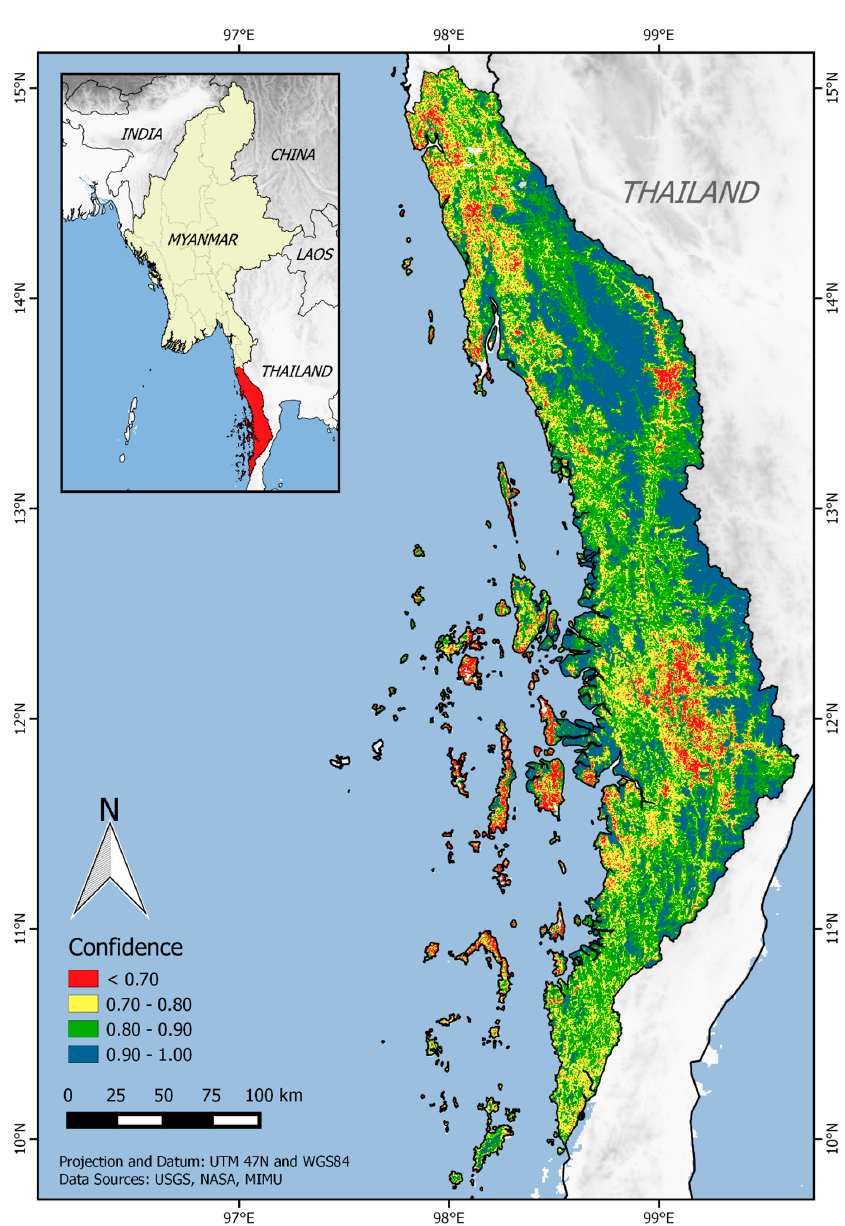
Figure 2. Map of Bayesian posterior probabilities for the land cover classification of Tanintharyi Region, Myanmar. High values indicate locations for which model-based assignment to a land cover class had high certainty. All pixel values are resampled to represent the mean posterior probability for each 500 m × 500 m neighborhood.